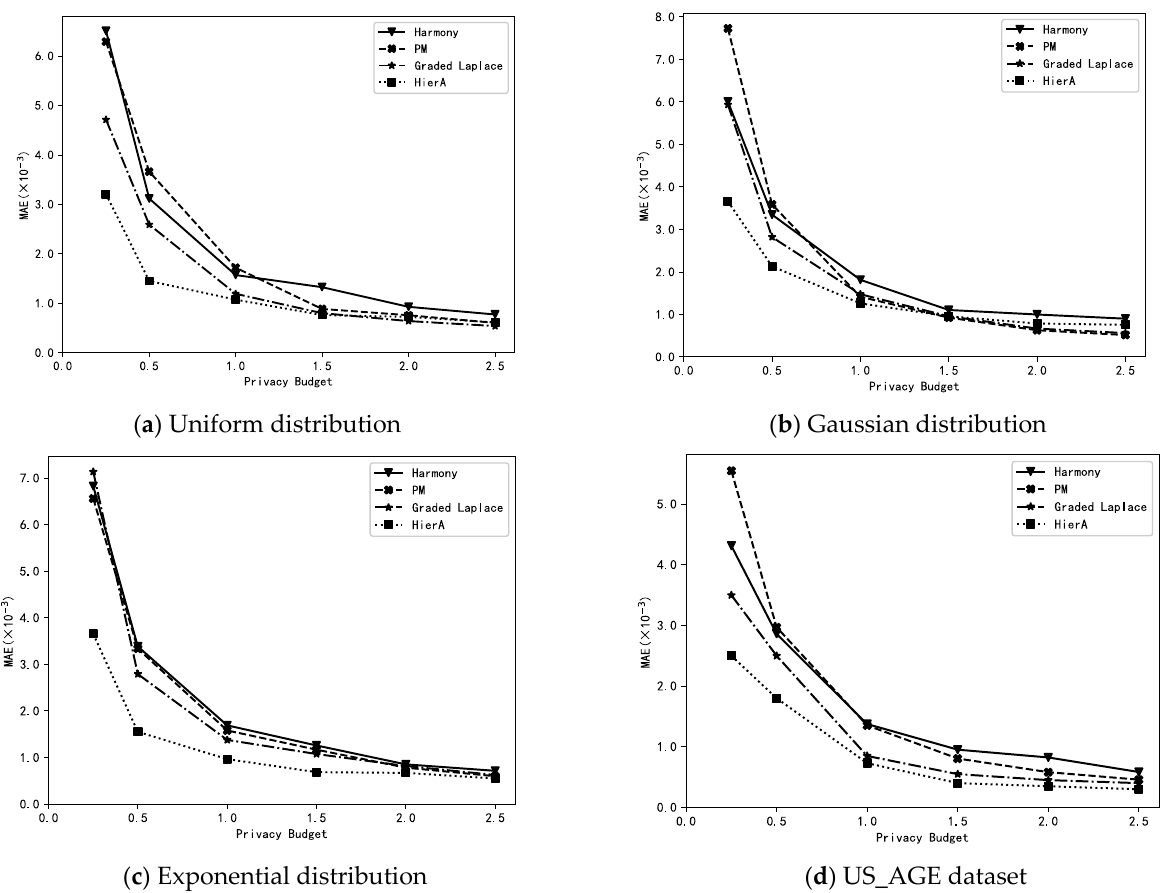
Figure 2. Estimations of the mean using different methods.